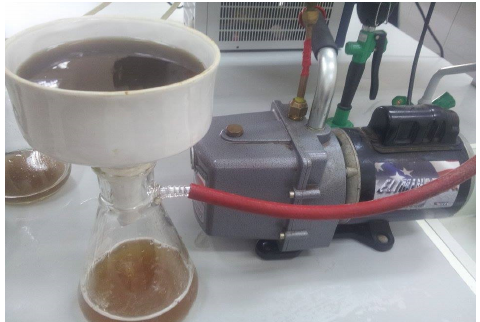
Fig. 2. Vacuum pump for washing and filtration process.